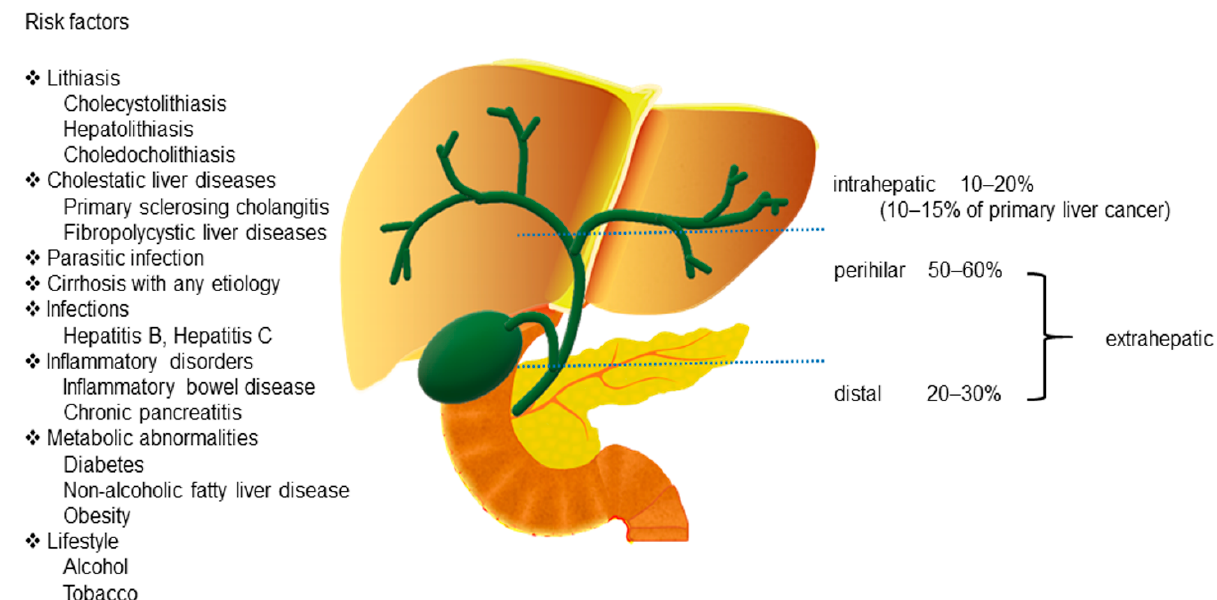
Figure 1. Anatomical classification of cholangiocarcinoma and its risk factors.